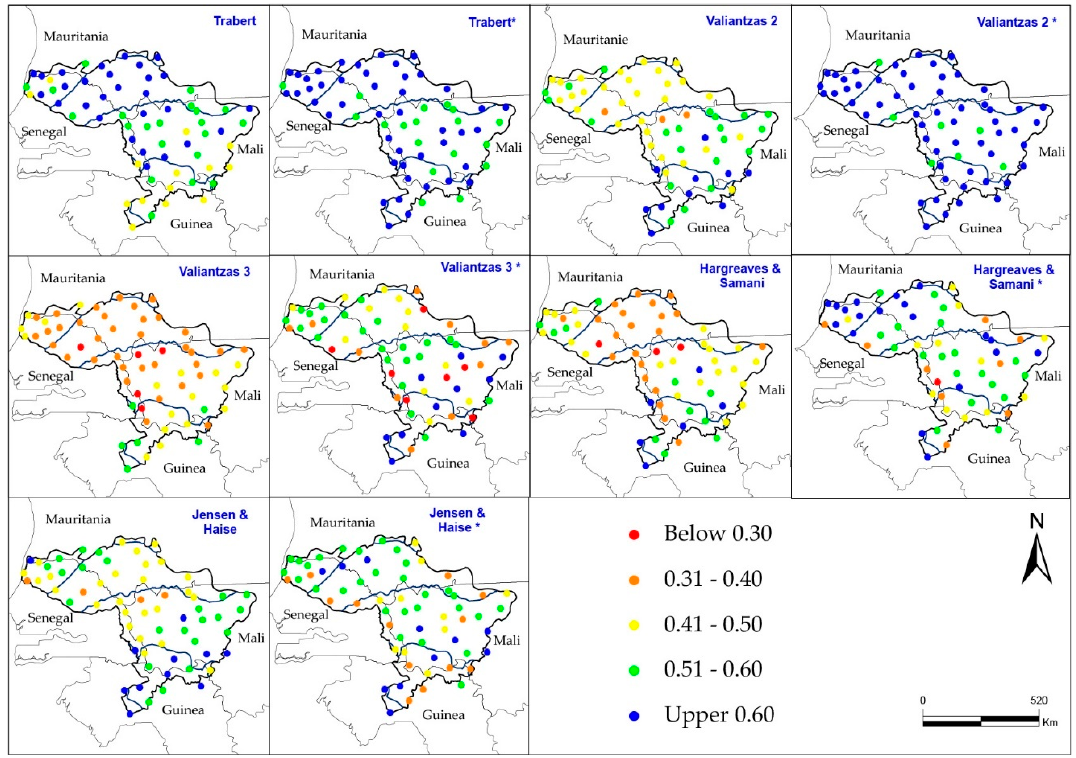
Figure 5. KGE values obtained after calibration of the best methods over the period 1984–2005. (* calibrated methods).